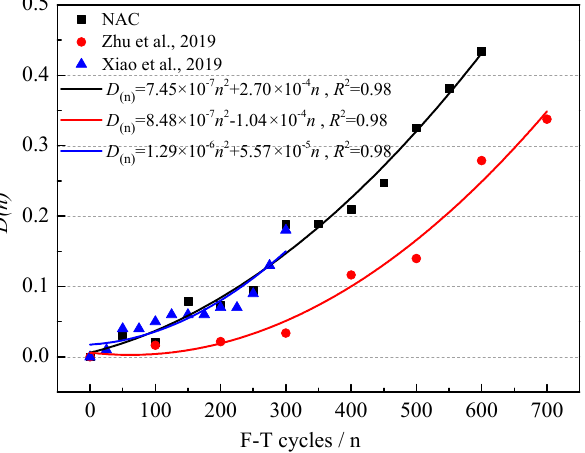
Figure 6. The variation of D (n) of NAC during F-T cycles [18,42].